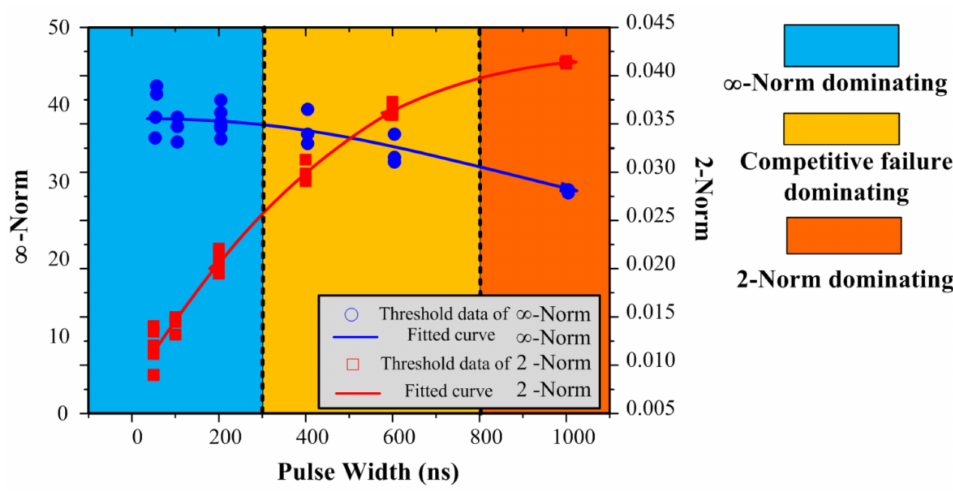
Figure 8. Fitted curves of threshold data of ∞ -norm and 2-norm.